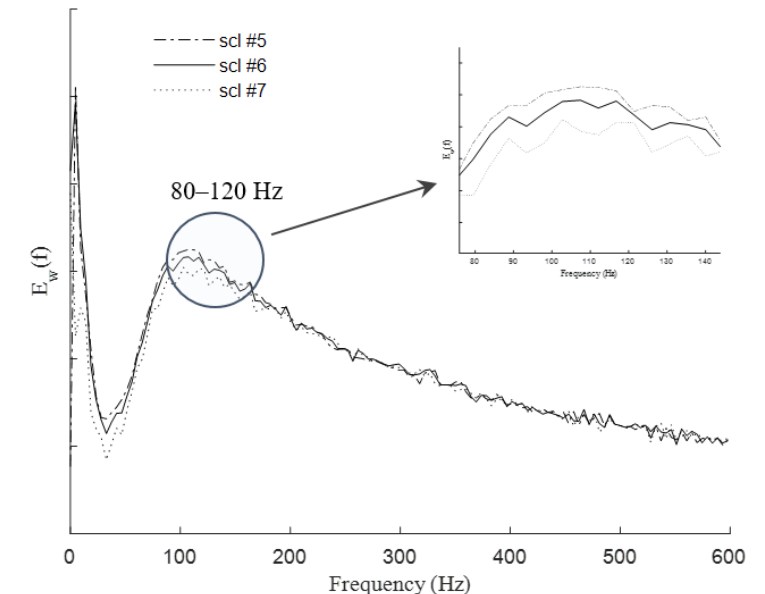
Figure 2. Frequency dependent wavelet energy spectrum using rbio2.8 scales 5 – 7.